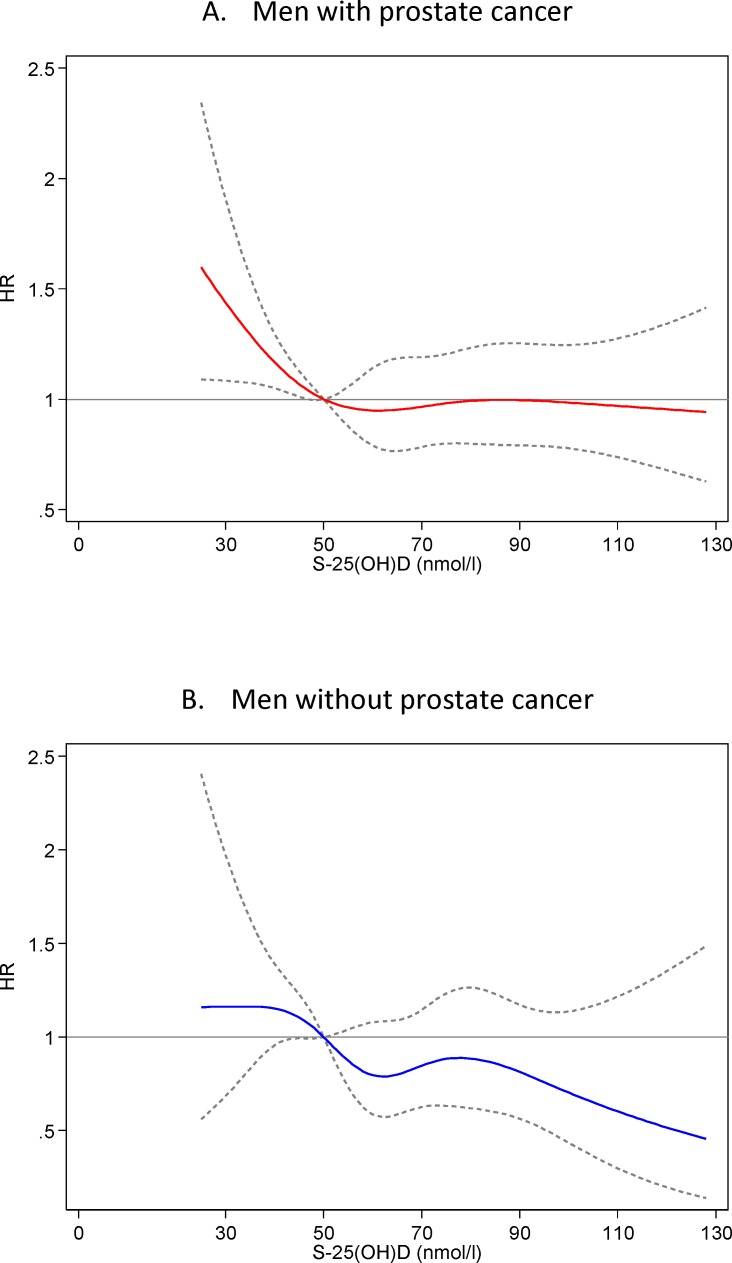
Hazard ratios (solid lines) with 95% confidence intervals (dashed lines) for all-cause mortality across the distribution of 25(OH)D in (A) men with prostate cancer and in (B) men without prostate cancer. Adjusted for age, month of blood sampling, examination, physical activity, BMI, smoking and education. 25(OH)D was included as restricted cubic splines with five knots.